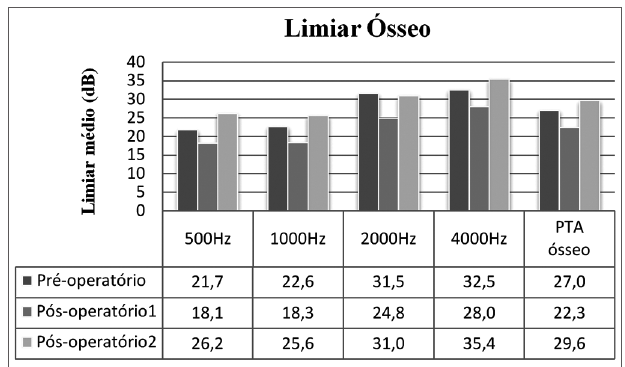
Figura 2. Limares ósseos médios para cada frequência auditiva e PTA ósseo médio. Diferença aéreo-óssea (DAO) Verificou-se uma melhoria da DAO em todas as fre- quências no pós-operatório imediato ( p < 0,01). Esta DAO também se alterou ao longo do tempo, com tendência